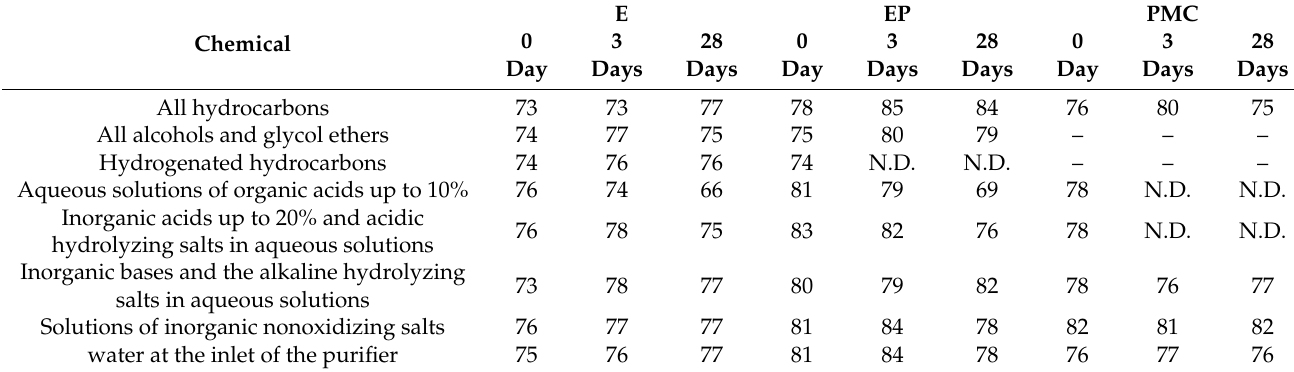
Table 6. Resistance to chemical aggression (hardness shore